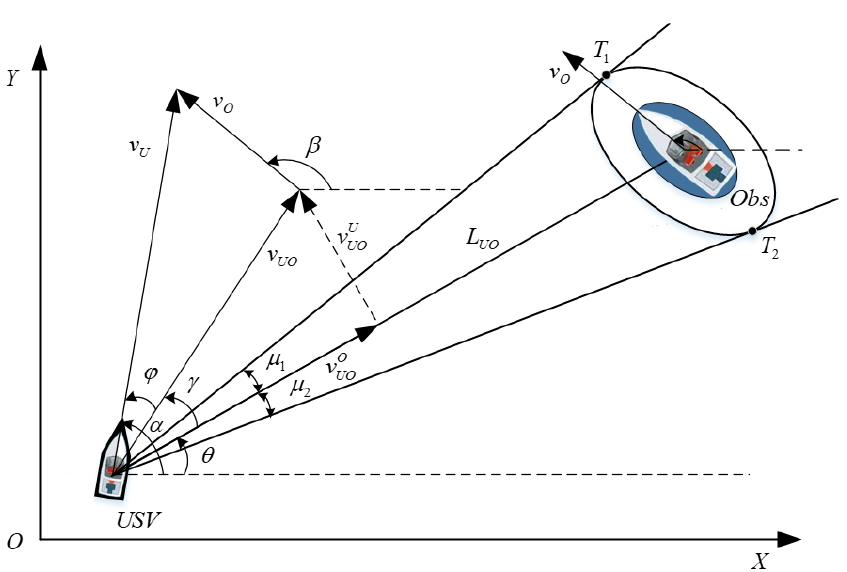
Figure 3. Ellipse obstacle avoidance